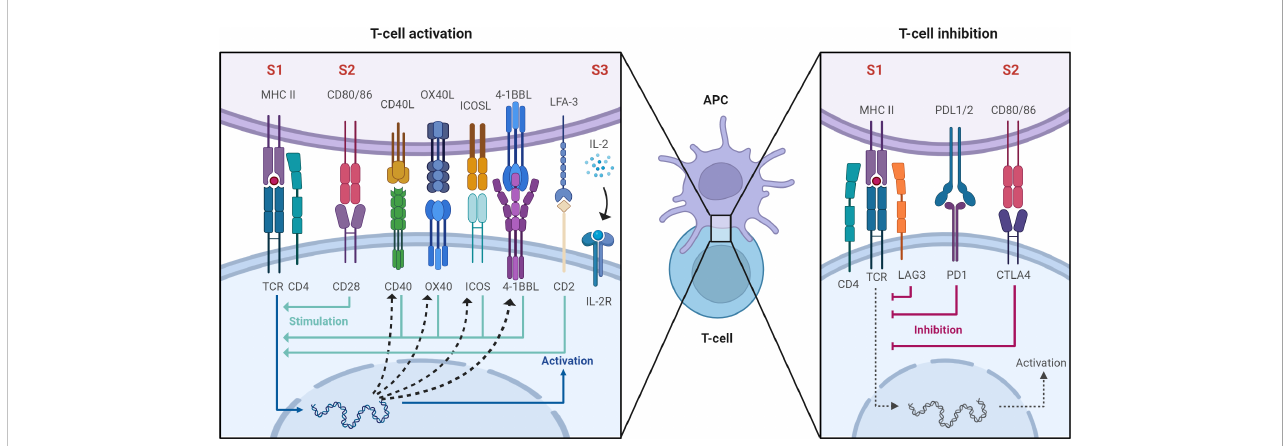
FIGURE 1 After antigen speci fi c allorecognition via the antigen-speci fi c TCR-MHC interaction (signal 1, labeled S1) second order signals are required for full T cell activation (S2 and S3). These involve engagement of immune checkpoints which are receptor-ligand pairs belonging to either the TNF or immunoglobulin superfamily. These act to either co-stimulate or co-inhibit the T cell response. Created with